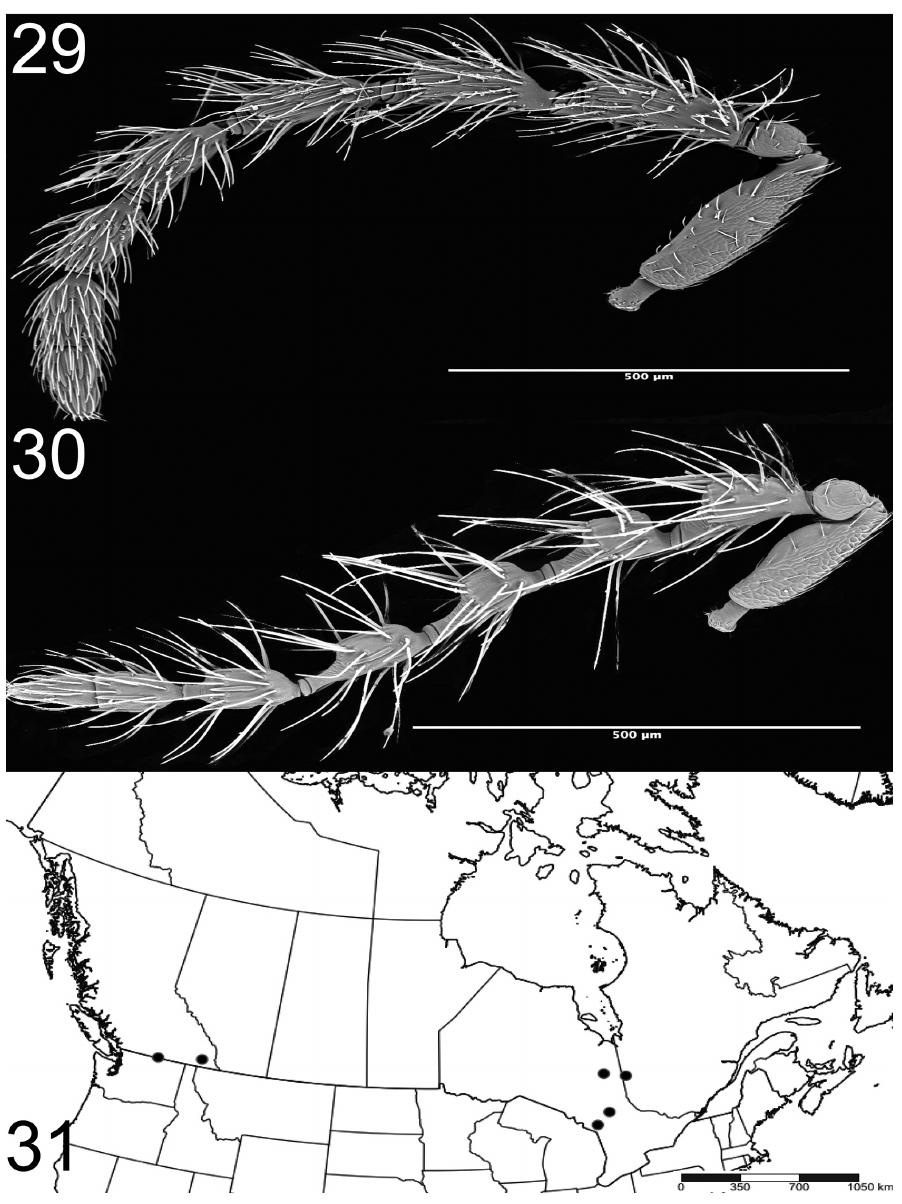
Figure 29–31. Eurytoma discordans 29 Male antenna. E. longavena 30 Male antenna 31 Known localities of Tenuipetiolus ruber in